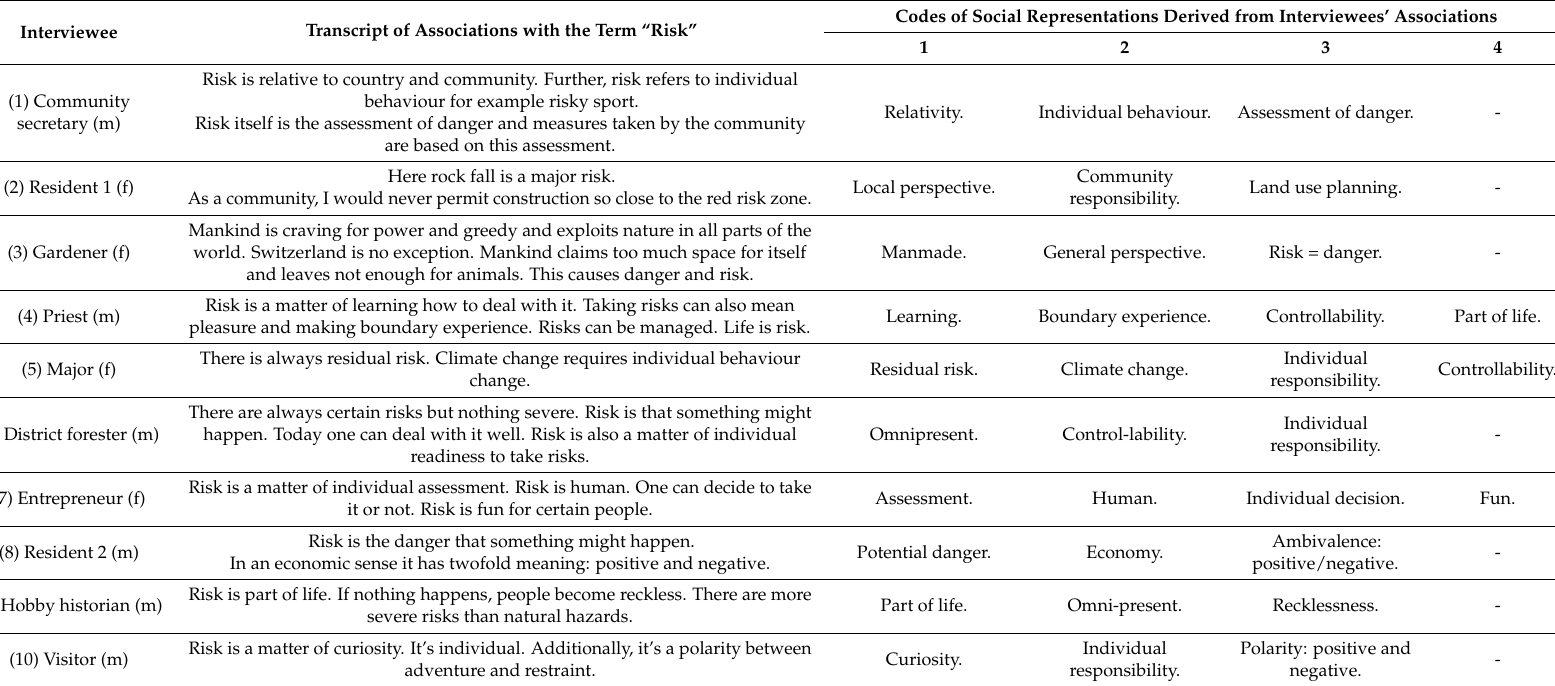
Table 3. Social representations of risk in